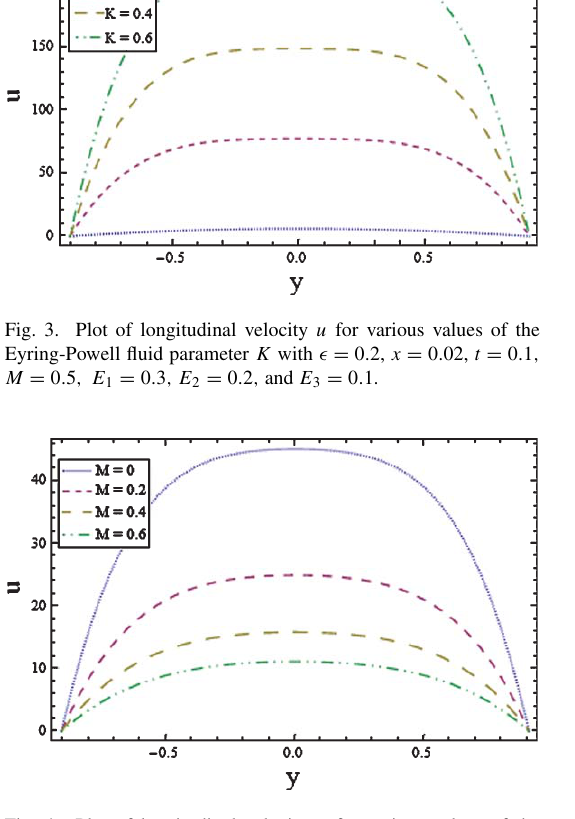
Fig. 2. Plot of longitudinal velocity u for various values of the wall propertiesparameterswith (cid:15) = 0 . 2, x = 0 . 02, t = 0 . 1 M = 0 . 5 , and K = 0 . 02.